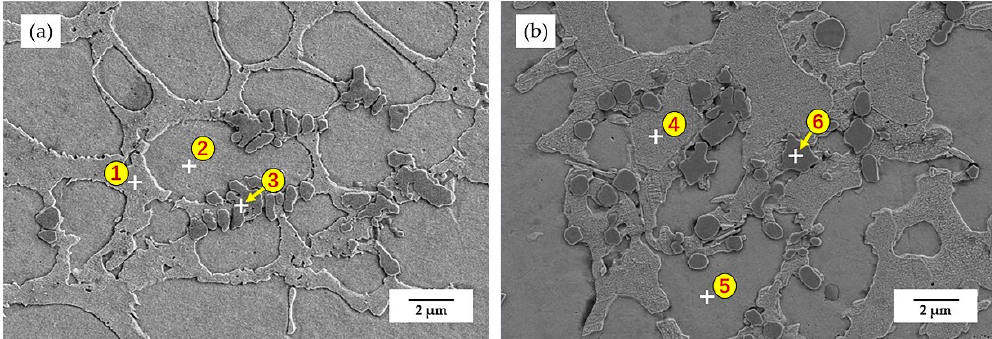
Figure 9. Microstructure of the upper area in the cladding layer: ( a ) 55NiTi coating; ( b ) 55NiTi + 5Ni coating. Table 3. EDS results of spectra scan for the marked positions in Figure 9.